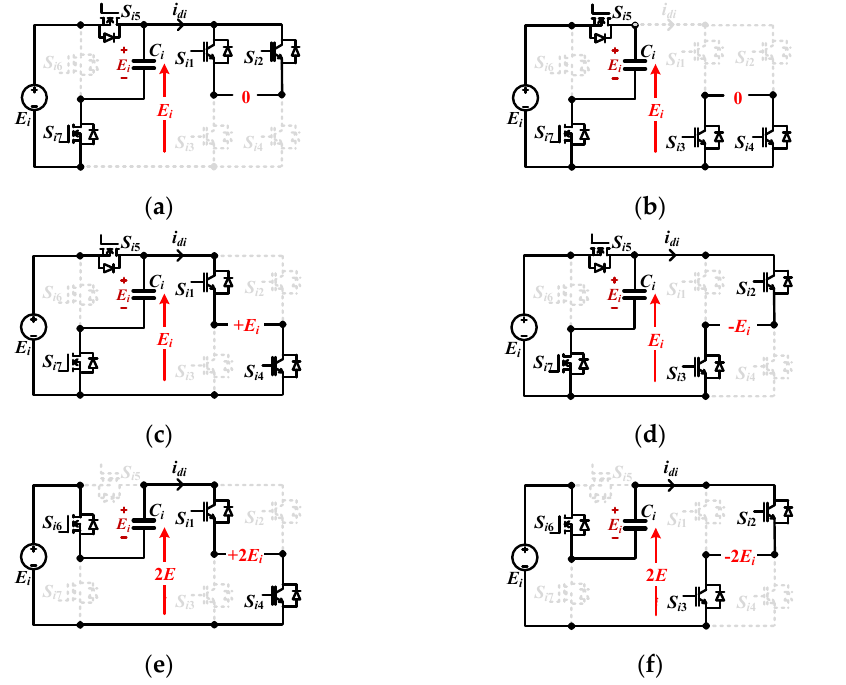
Figure 2. Switching modes of an optimized cascaded unit. ( a ) Mode 1, ( b ) Mode 2, ( c ) Mode 3, ( d ) Mode 4, ( e ) Mode 5, ( f ) Mode 6. Table 1. Working status of the cascaded